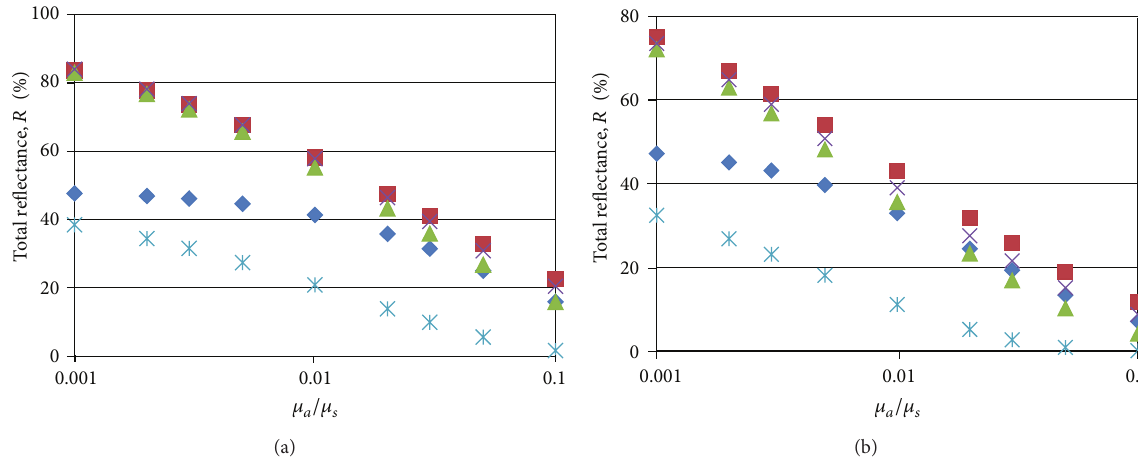
Figure 4: Total diffuse reflectance as a function of 𝜇 𝑎 /𝜇 𝑠 ratio for different models ( 𝑔 = 0.757 (a), 𝑔 = 0.908 (b)): diffuse approximation (8) (squares), single back scattering model (SBS) (rhomboids), path integrals (triangles), Kubelka-Munk (crosses), and diffusion dipole model (7) (stars).